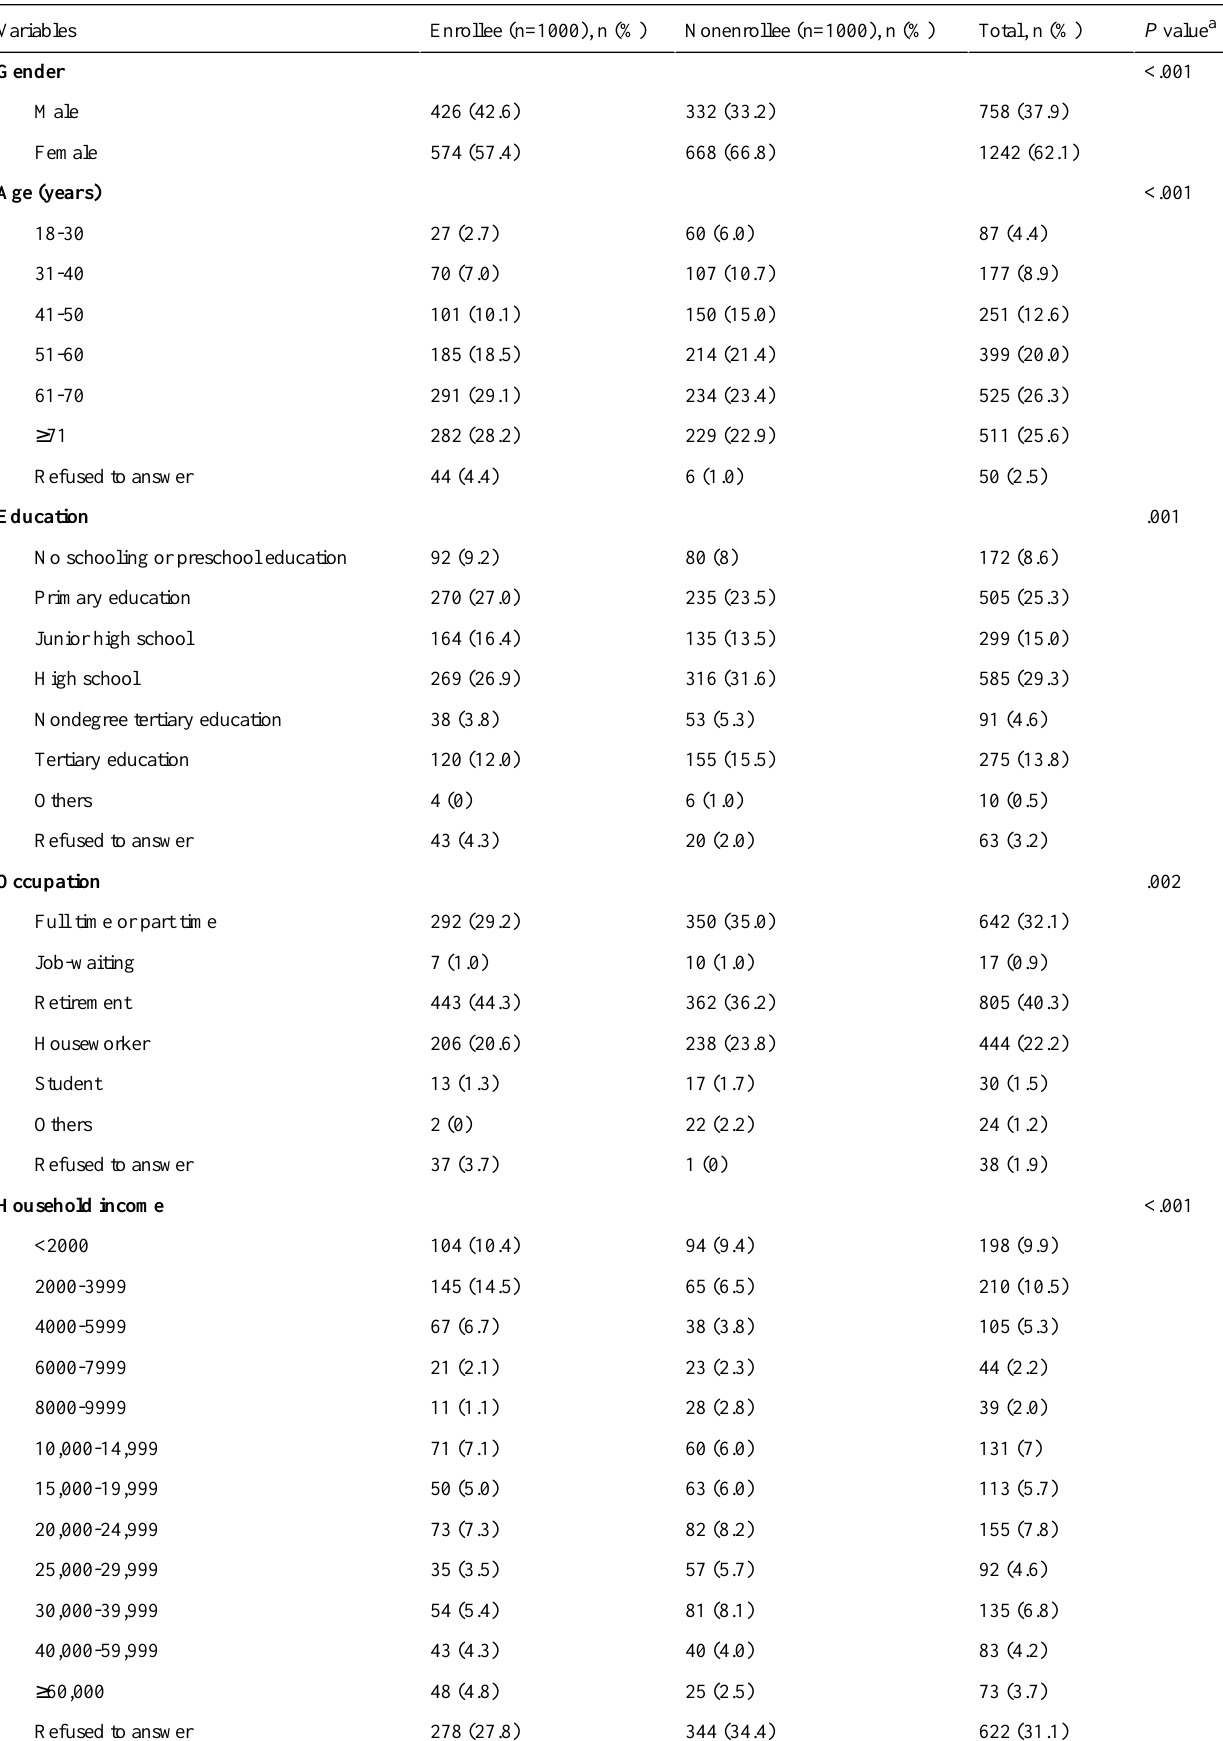
Table 1. Sociodemographic characteristics of patients